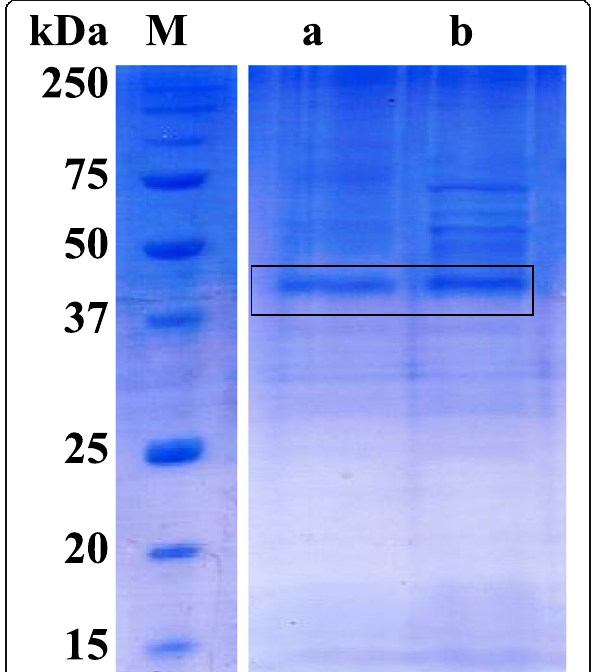
Fig. 2 SDS-PAGE of the LipEMP48-D non-optimization ( a ) and codon optimization ( b ). Marker precision plus protein standards